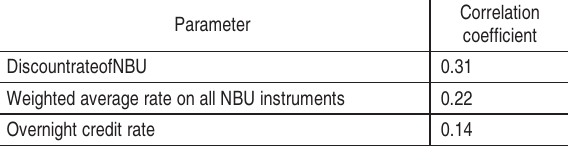
Table 7. Correlation matrix characterizing Ukrainian real estate market reaction to the changes of MP instruments (monthly data) for 2006-2015*